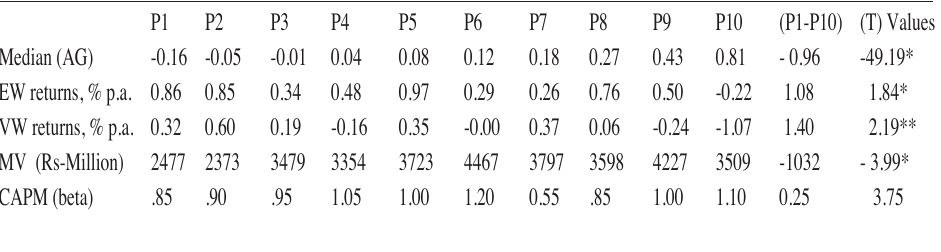
Table 1: Characteristics of Asset Growth in Deciles Portfolios of Full Sample (2001-2015) P1 P2 P3 P4 P5 Median (AG) EW returns, % p.a. 0.86 0.85 VW returns, % p.a. 0.32 0.60 MV